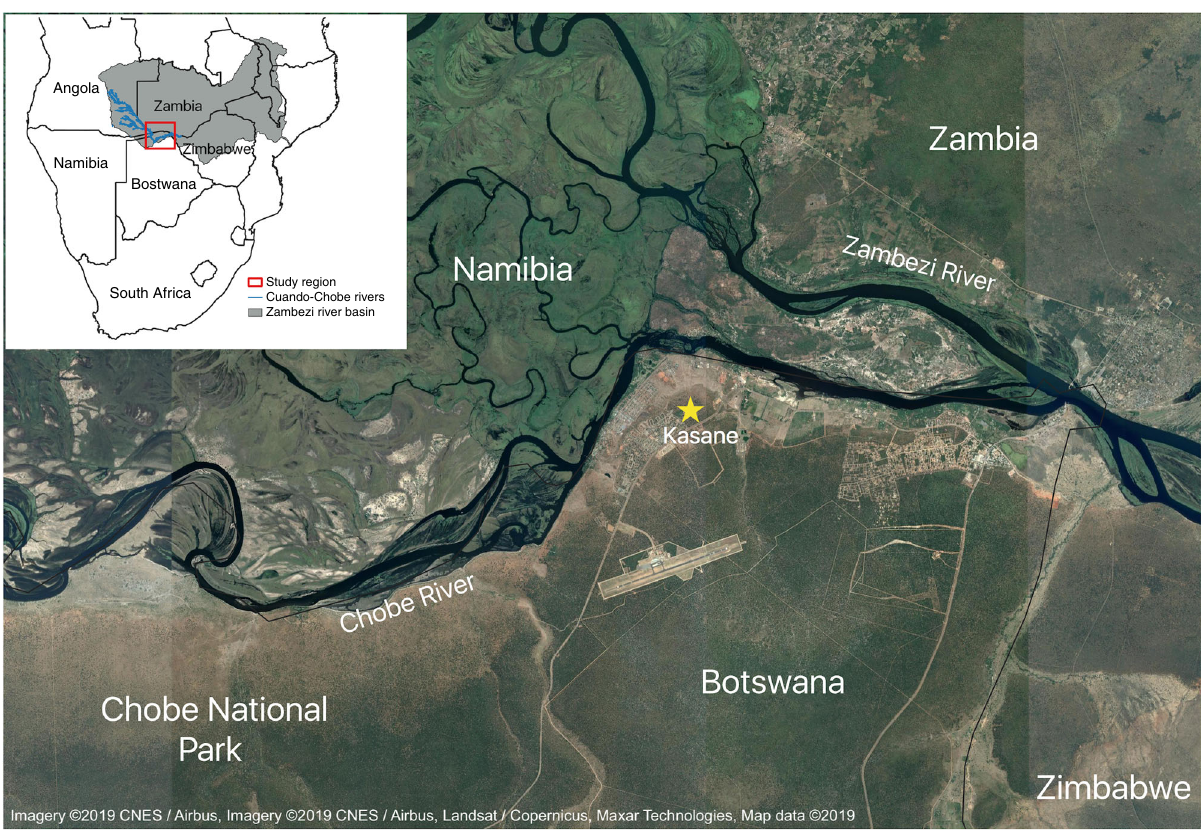
Fig. 1 Map of study region in Chobe District, Botswana. Chobe District is located in the northeastern region of Botswana, and is situated at the southern edge of the Zambezi river basin (inset). A majority of people in the district reside in or near Kasane along the Chobe River, which is fed by the Cuando River system and originates in the Angolan highlands. Table 1 Correlations between Niño 3.4, environmental variables, and under-5 diarrhea. Diarrhea anomalies Rainfall anomalies Chobe River height anomalies Minimum temperature anomalies Niño 3.4 lag